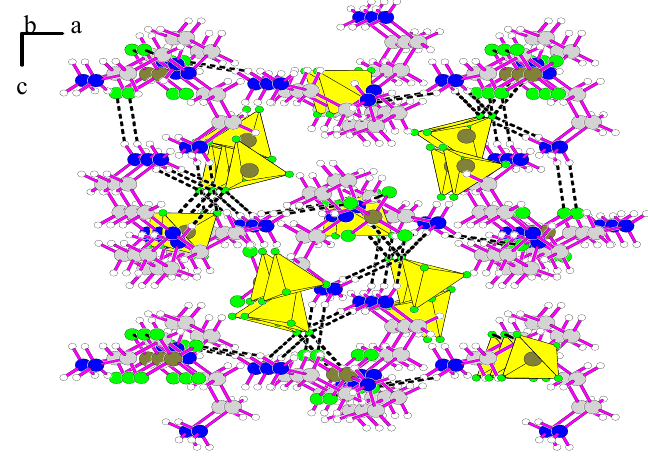
Figure 1. View of the structure of [H 3 tren ](BF 4 ) 3 .